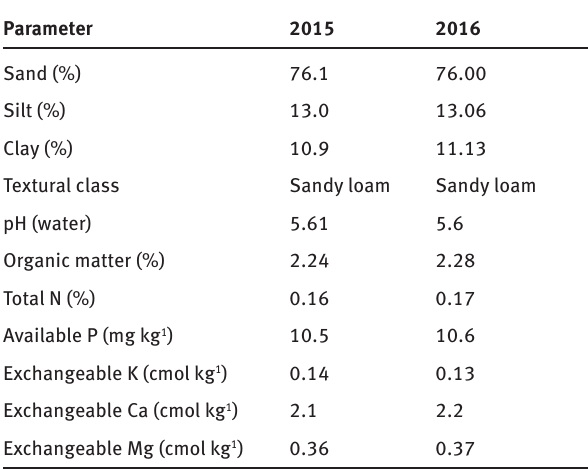
Table 1: Physio-chemical properties of the soil prior to commence-